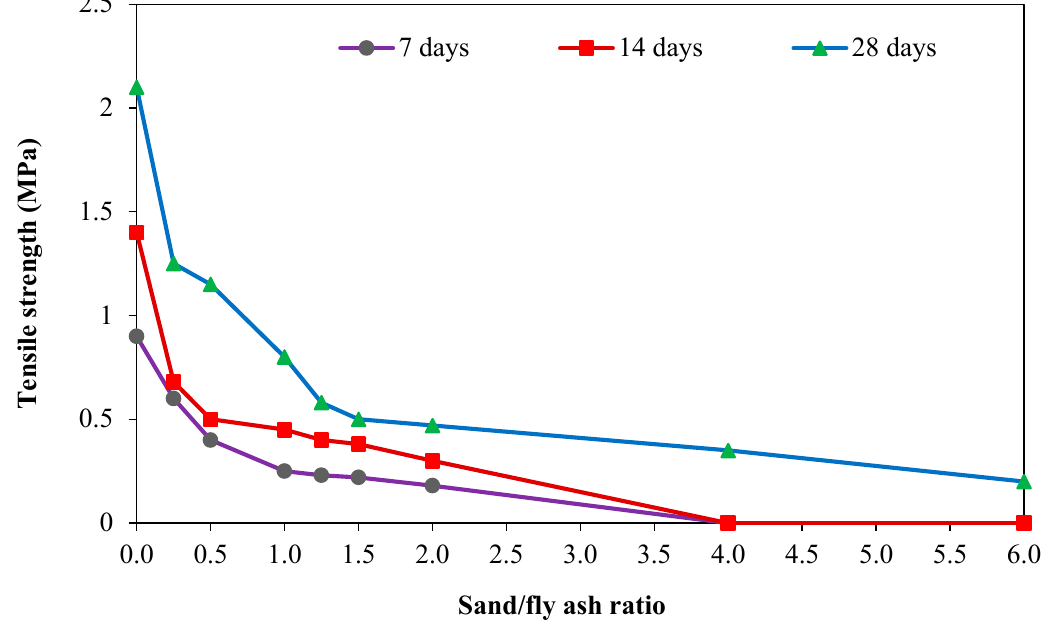
Figure 18. GPC tensile strength of different sand/fly ash ratios [84].